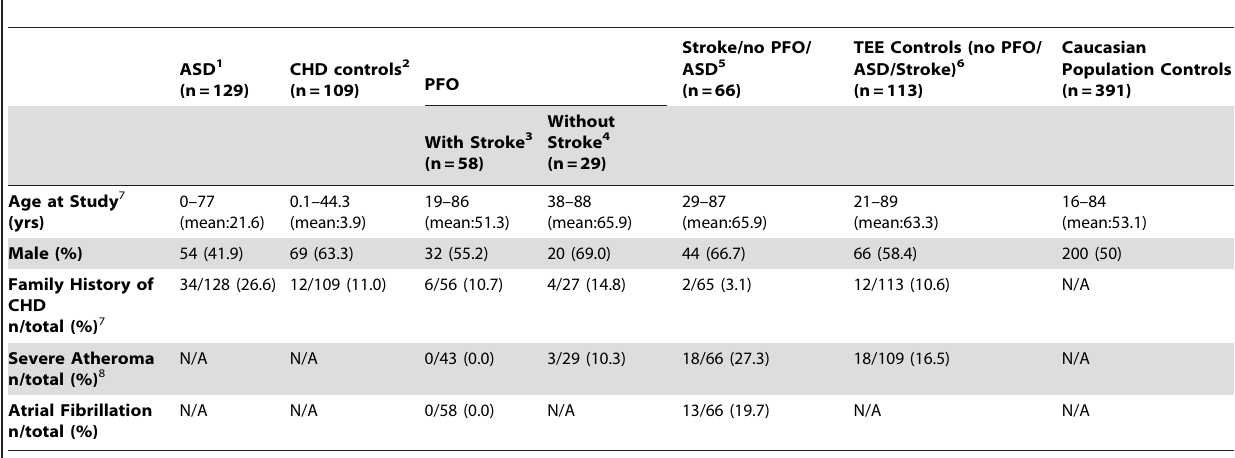
Table 2. Clinical characteristics of Australian cohort.